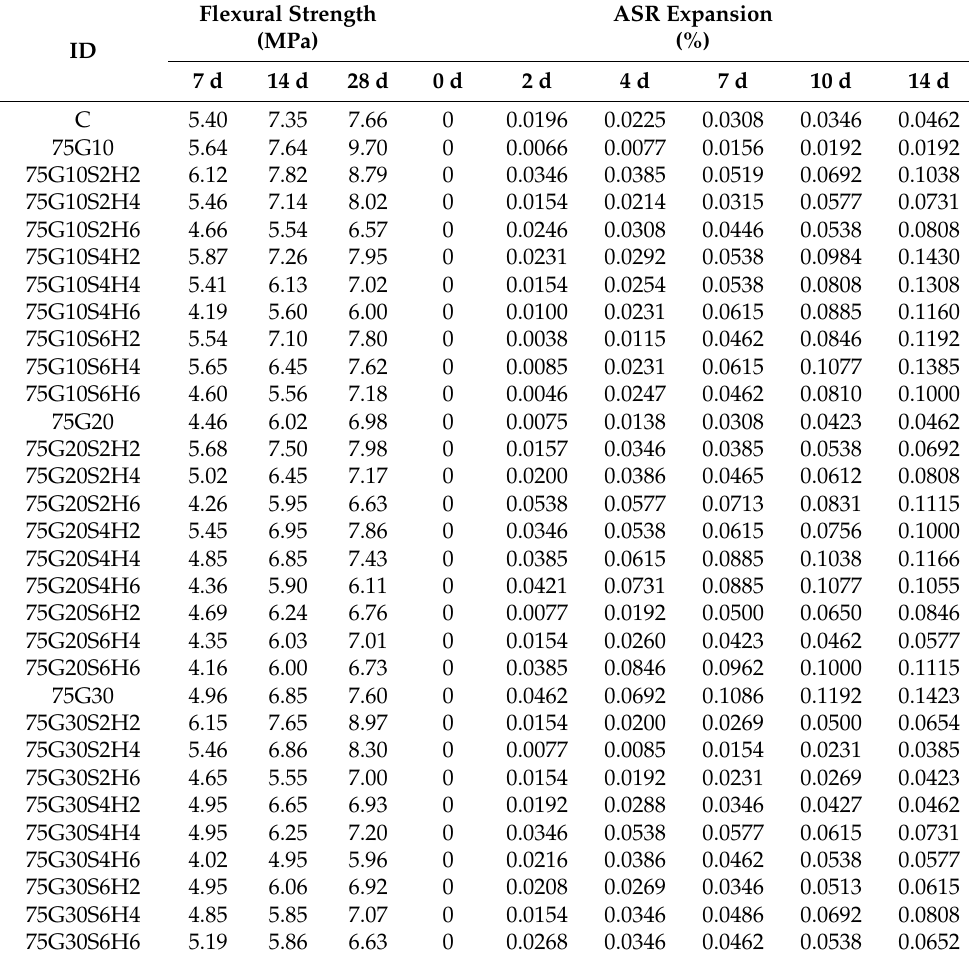
Table A1. The experimental results of 75 µ m WGP mortar